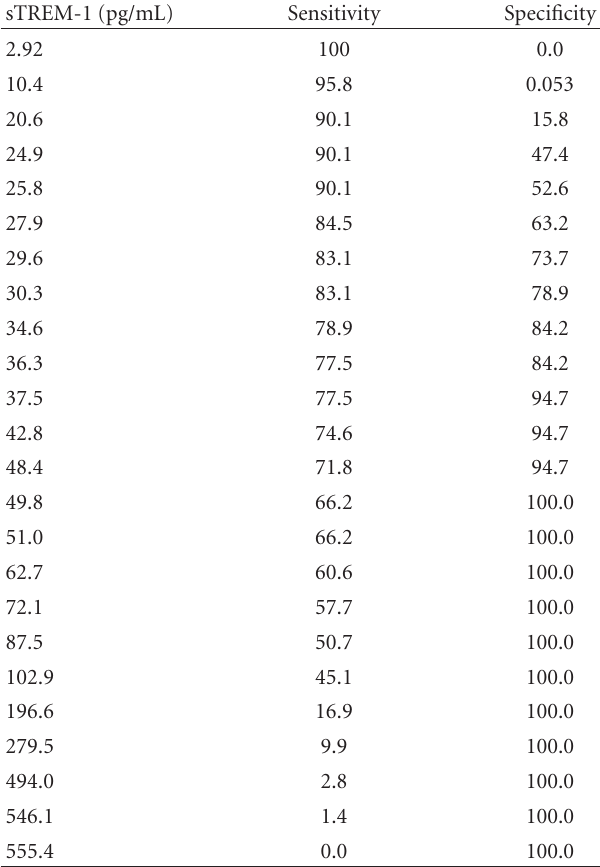
Table 6: Sensitivity and specificity of sTREM-1 test. Coordinates of the